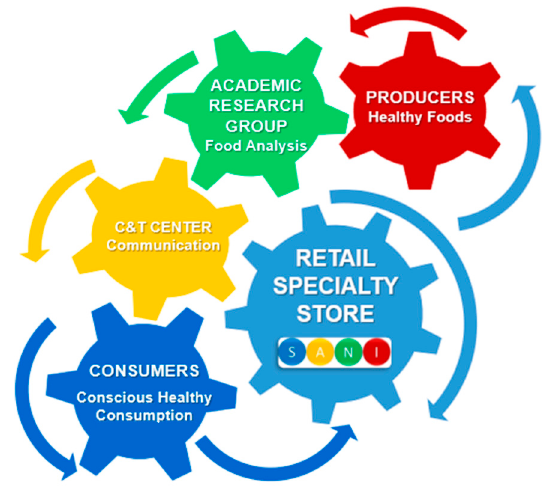
Figure 2. SANI (Italian for “healthy”) partners and